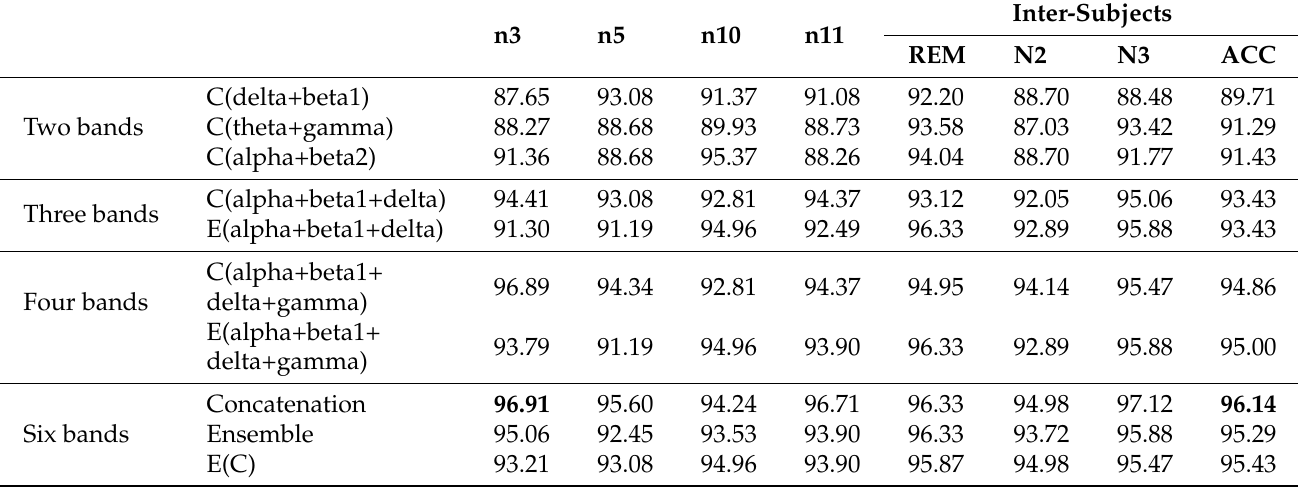
Table 3. Classification accuracy (%) of PLV value with band fusion strategies. For inter-subject case, the true positive rate of each class is